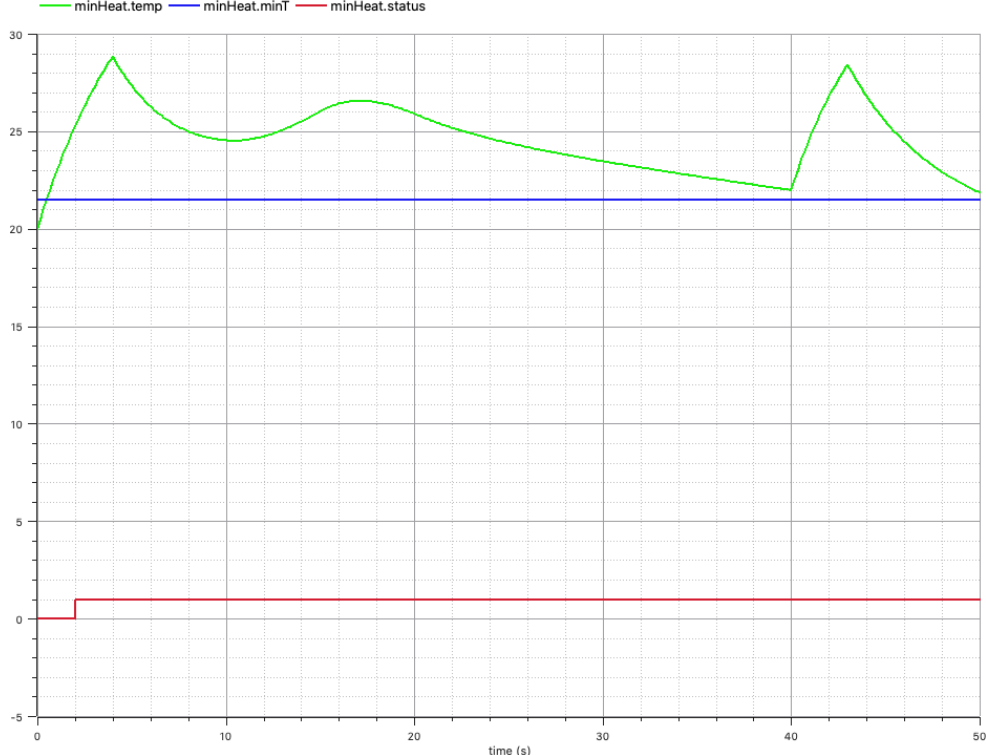
Figure 9. Requirement Req. 003 is fulfilled for the sunny